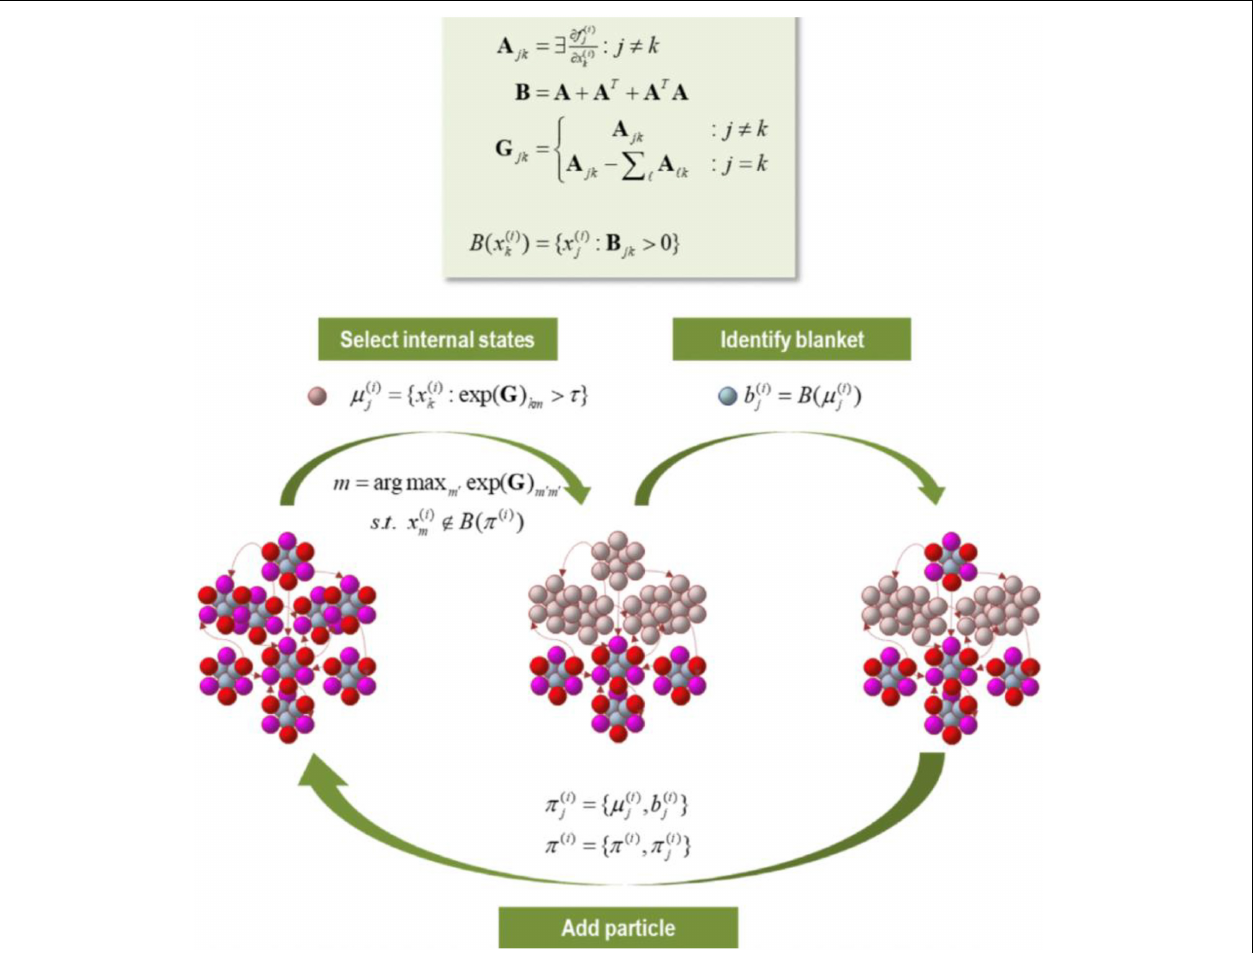
FIGURE 9 | In this figure we have a partition of eigenstates (small colored balls) into particles, where each particle displays 6 blanketed states (active states in red; sensory states in magenta), and 3 internal states (cyan). Based upon the Jacobian and implicit flow of vector states, an adjacency matrix characterizes the coupling between vector states, which defines the blanket forming matrix (B), and to form a Laplacian (G) that is used to define coupled internal states. The internal and blanket states then form a new particle. The procedure is exhausted when unassigned vector states belong to the Markov blanket of the particles identified